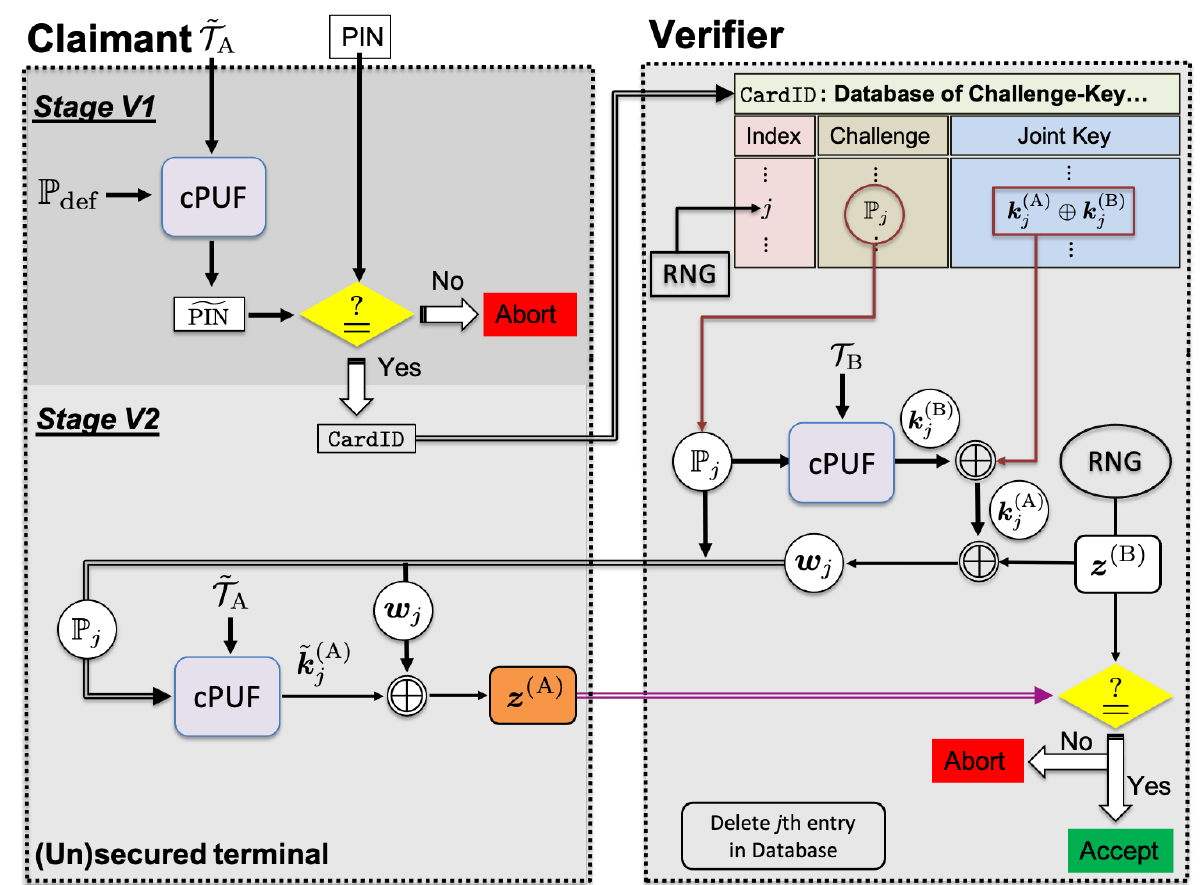
Figure 4. Schematic representation of the two stages in the verification of a user (claimant) to the system for the protocol of Section 3. The claimant inserts her token in an (un)secured terminal and types in her PIN. Stage V1 takes place locally, and during this stage, the claimant is authenticated to the token. If stage V1 is successful, the terminal contacts the verifier who has access to the database of challenge-key pairs associated with the particular token. Stage V2 aims at the verification of the token, which represents the user to the system. The verifier chooses at random one of the rows in the database, and sends a copy of the associated challenge to the terminal. In principle, a malicious user is allowed to deviate from the depicted procedure, as well as to control various components in the terminal. The parameters of the light P def used in stage V1 are publicly known. Irrespective of the outcome, the data that have been used in the verification are removed from the database at the end of the session. Double-line arrows show classical communication between the verifier and the